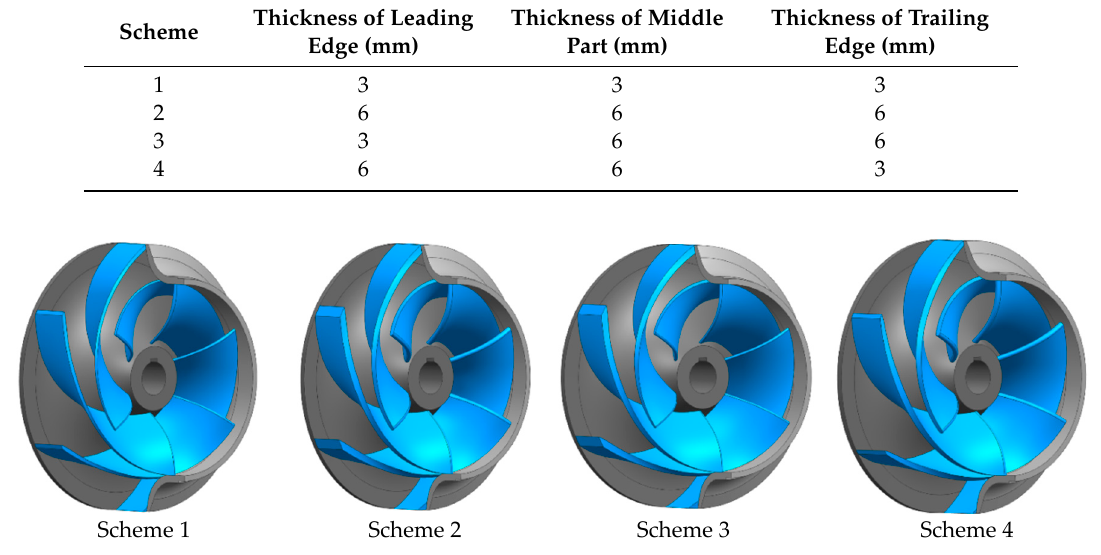
Figure 4. The 3D models based on four blade thickness distribution schemes given in Table 2.